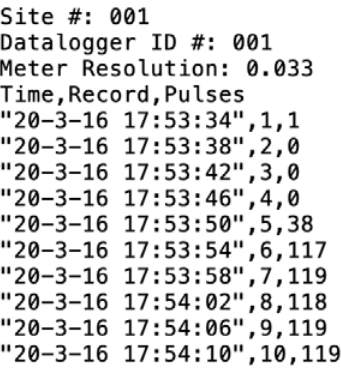
Figure 3. Sample output from the Cyberinfrastructure for Intelligent Water Supply (CIWS) datalogger collecting data with a 4 s time interval. The data is stored in a comma separated values (CSV) file, which is easily operable in multiple platforms and software.